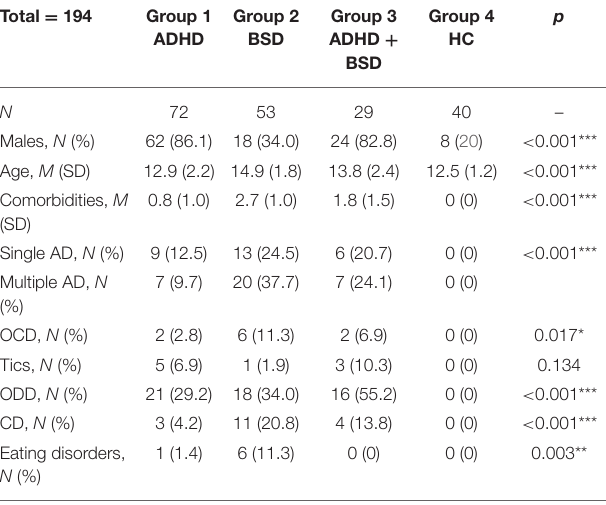
TABLE 1 | Demographic and clinical characteristics of the